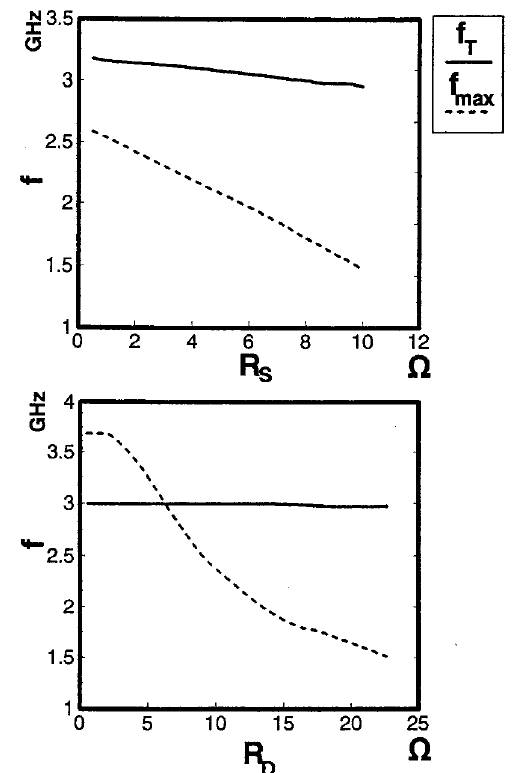
FIGURE 11 The dependence of R D , R S on frequency